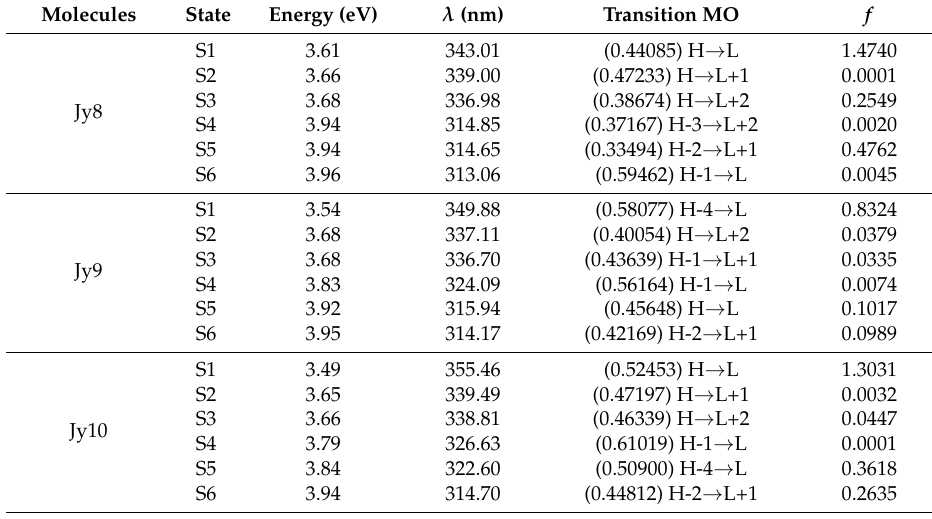
Table 5. Calculated transition energies, absorption peaks λ , major transition molecular orbitals and oscillator strength f of the three designed molecules